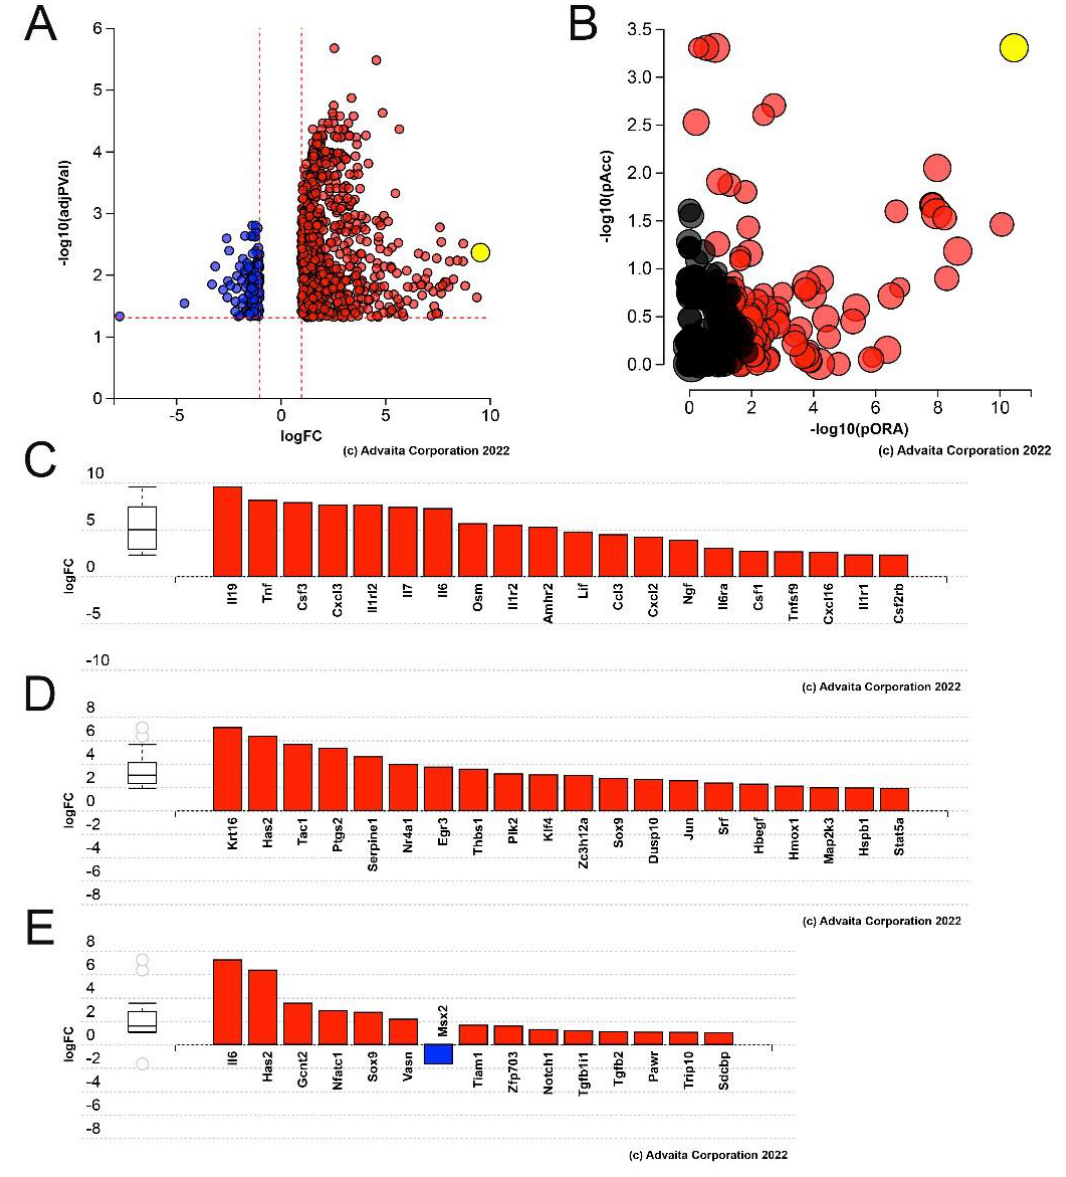
Figure 1. Advaita iPathway analysis of genes differentially expressed at 6 h PCS in LECs. ( A ) Volcano plot of genes (represented by either a blue dot for negative fold change or red dot for positive fold change) whose expression was statistically different in 6 h PCS LECs. Yellow dot represents Il19. ( B ) Impact analysis of the 6 h PCS DEGs predicting that the KEGG pathway “cytokine-cytokine receptor interaction” ( p -value of 1.120 × 10 −8 ) (yellow dot) is the most significantly impacted pathway. While other impacted KEGG pathways are represented by the other dots with black dots being non-significant KEGG pathways and red dots being significant KEGG pathways. ( C ) Bar graph showing which cytokine-cytokine receptor interaction genes are differentially expressed in LECs at 6 h PCS. ( D ) Bar graph showing the “epithelial cell migration” ( p -value = 9.600 × 10 −5 ) genes differentially expressed in 6 h PCS LECs. ( E ) Bar graph showing the DEGs implicated in the “epithelial to mesenchymal transition” ( p -value = 0.003) pathway.